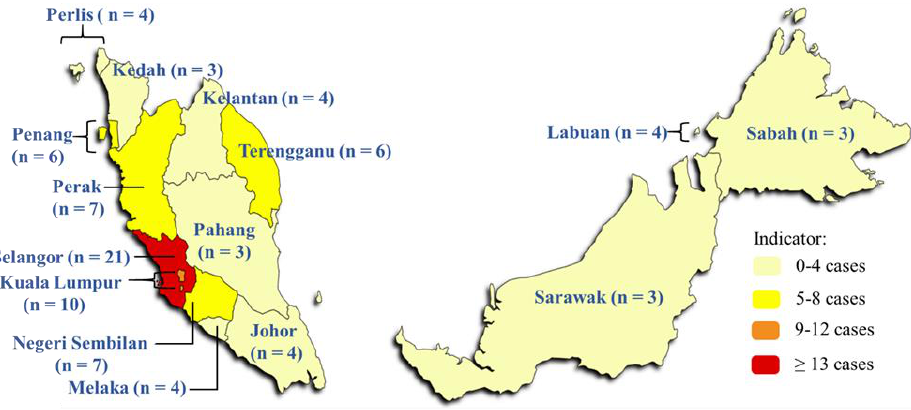
Figure 3. Number of questionnaire-based studies conducted in each state of Malaysia.